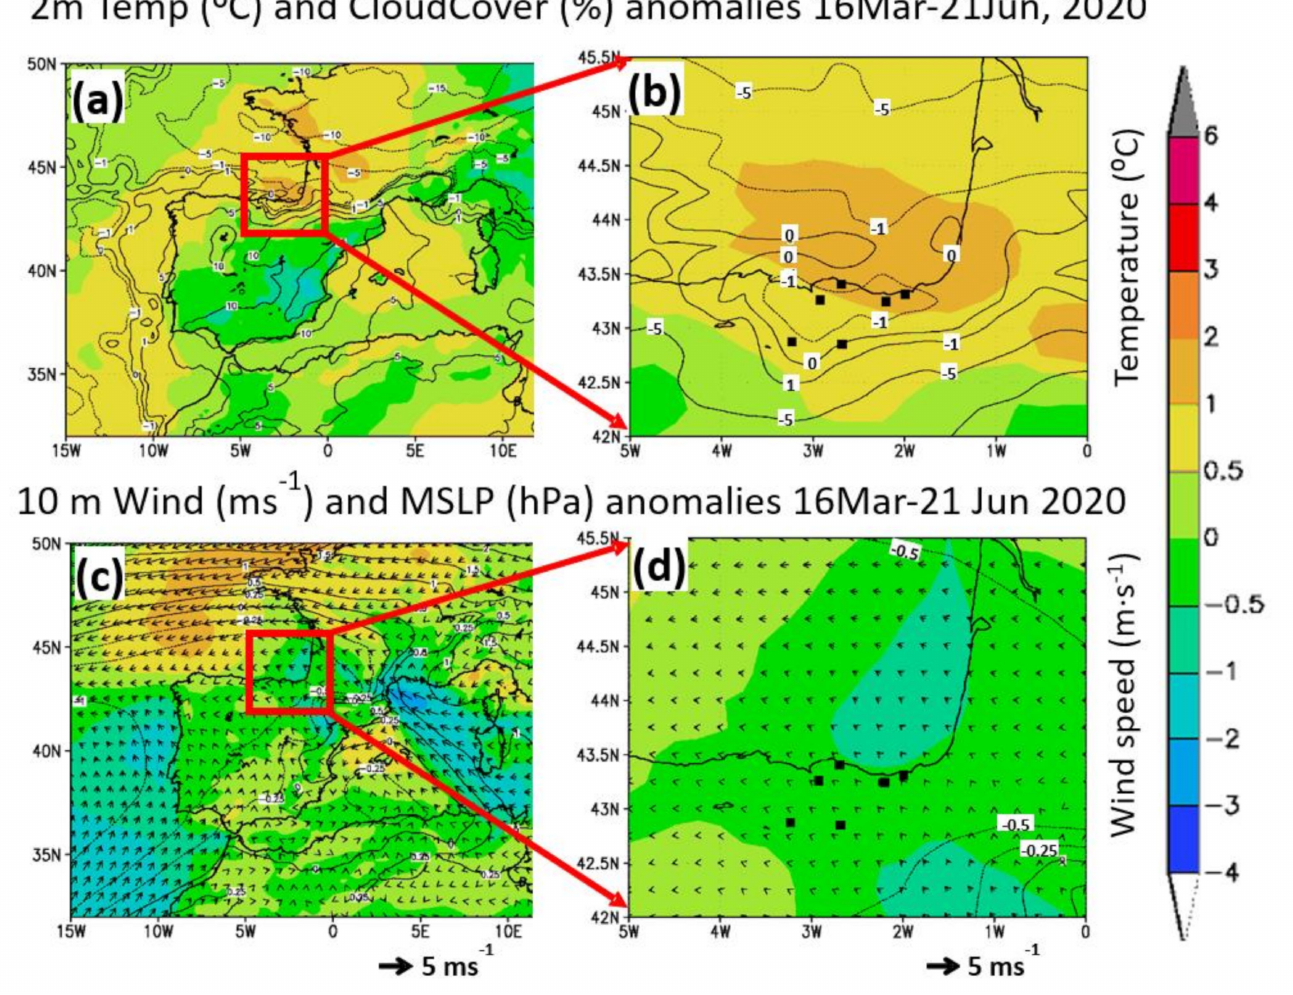
Figure 3. Temperature, cloud cover ( a , b ), mean sea level pressure, and wind anomalies ( c , d ) during the 2020 lockdown period with respect to the 2015–2019 corresponding